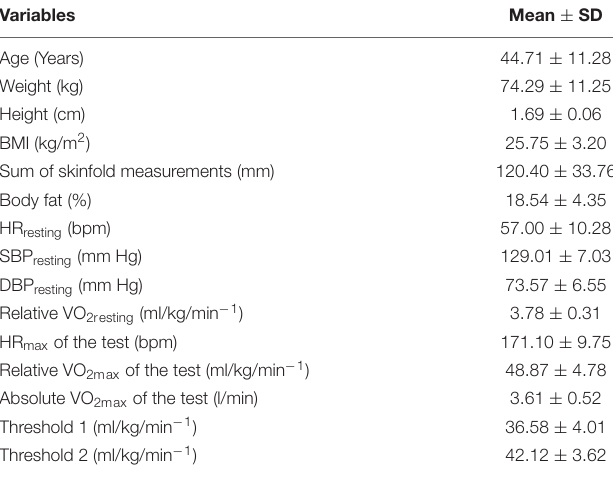
TABLE 1 | Age, anthropometric variables measured at rest and hemodynamic variables measured at rest and during the cardiopulmonary exercise test of the ultramarathon participants ( n = 7).